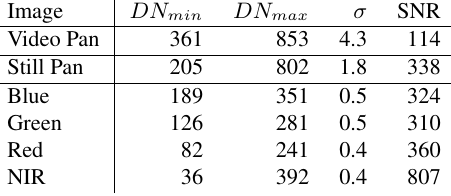
Table 4: Overall image noise of Skysat-1 video, panchromatic still and multispectral still